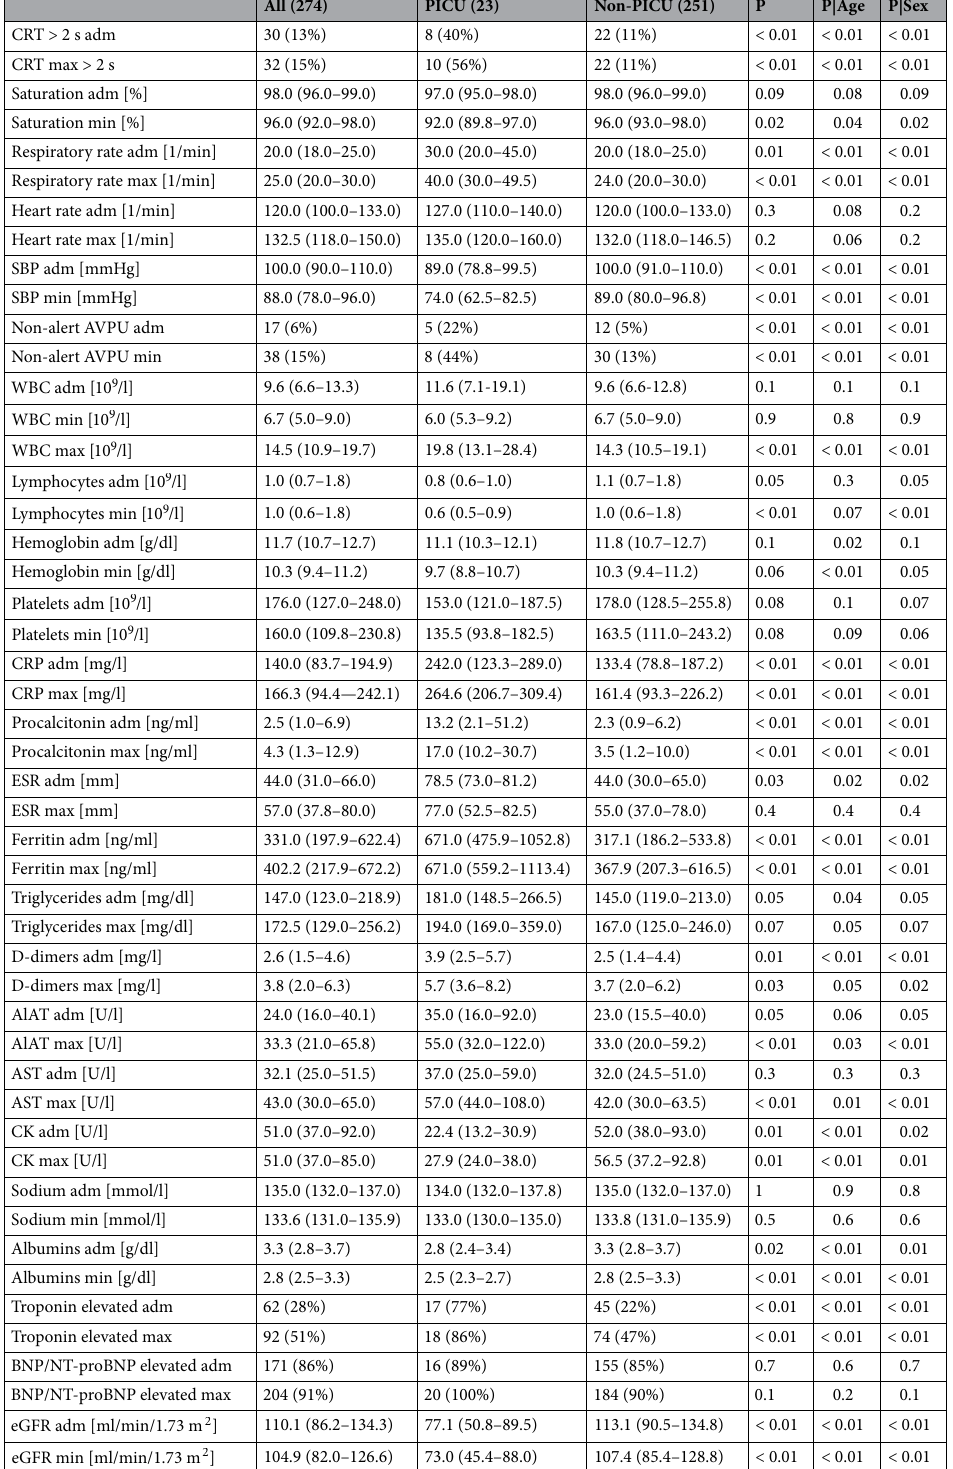
Table 2. Vital signs and laboratory results of MIS-C cohort at admission and at respective peaks. Binary data given as count (per-cent), and numerical data as median (interquartile range). Values at admission are marked with adm, lowest obtained with min, while highest with max. Troponin is considered elevated at > 50 ng/l, while BNP/NT-proBNP at > 150 ng/ml. AlAT , alanine transaminase, AST , aspartate transaminase, AVPU AVPU scale, BNP/NT-proBNP brain natriuretic peptide or N-terminal-pro-BNP, CK creatinine kinase, CRT capillary refill time, CRP , C-reactive protein, eGFR estimated glomerular filtration rate, ESR , erythrocyte sedimentation rate, MIS-C multisystem inflammatory syndrome in children, NT-proBNP N-terminal prohormone of brain natriuretic peptide, PICU , pediatric intensive care unit, SBP systolic blood pressure, WBC white blood cell count, P|Age age-adjusted p-value, P|Sex sex-adjusted